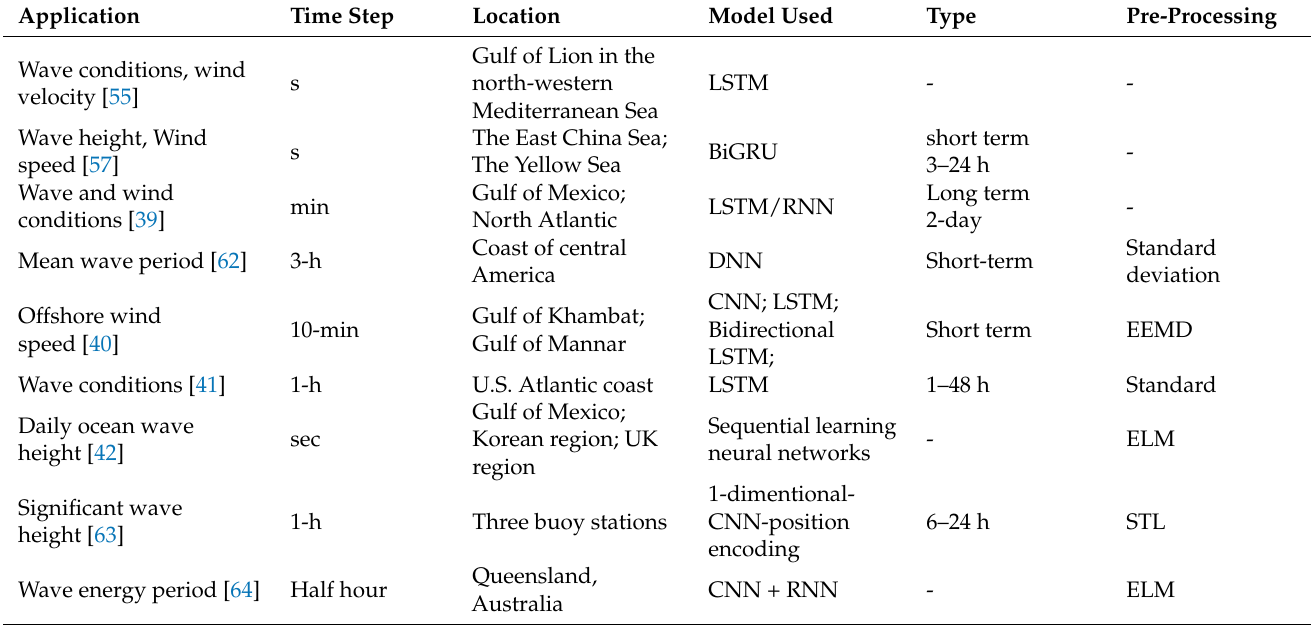
Table 2. Summary of wave forecasting models based on deep learning.